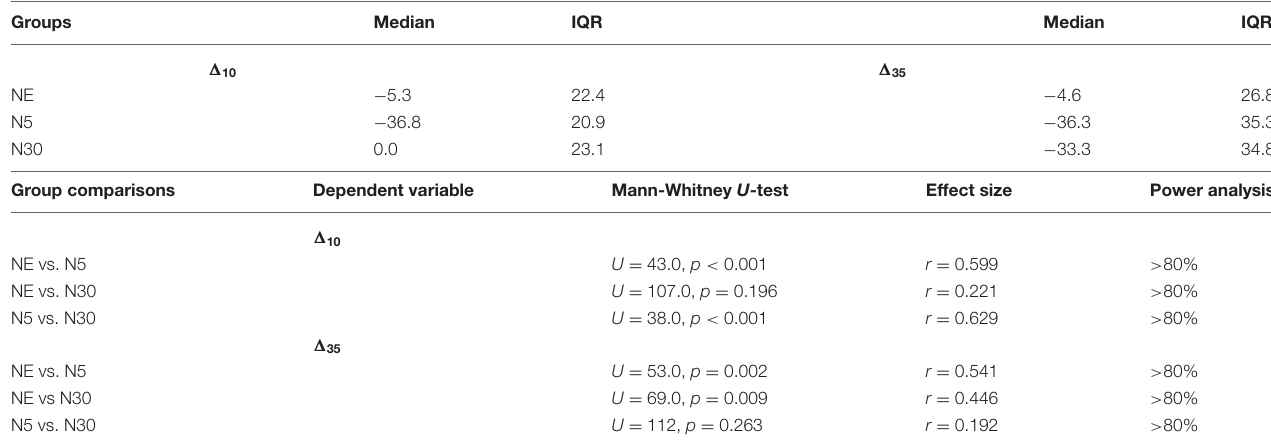
TABLE 3 | Median and interquartile range of percent change in CPT pain tolerance ( 1 10, 1 35 ) in the three experimental groups and between-group comparisons of CPT percental tolerance change.